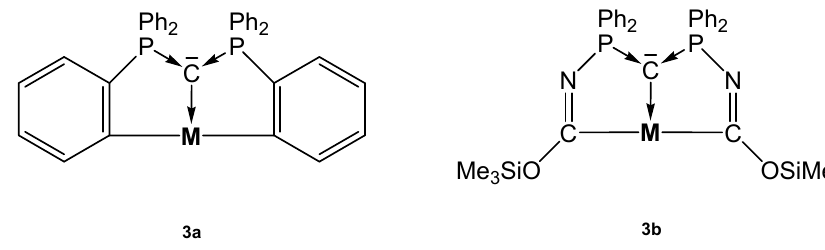
Figure 5. Bis-ortho metallated pincer complexes 3a and 3b .